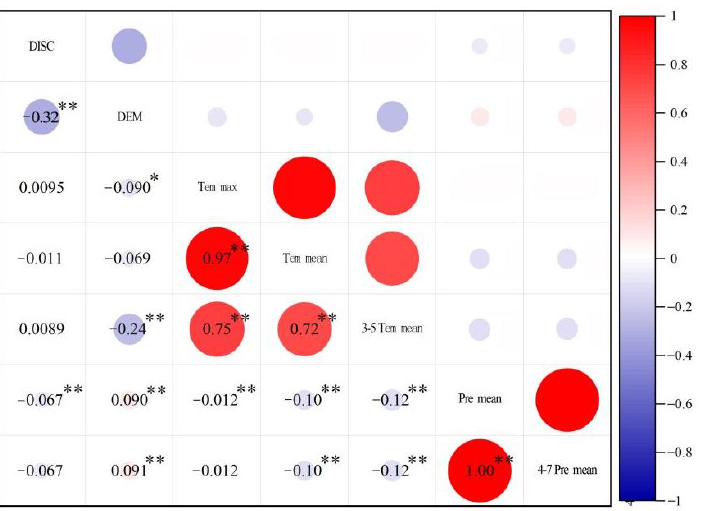
Figure 4. The correlation coefficients of the independent variables. (Note: * and ** represent 5% and 1% significance, respectively.)